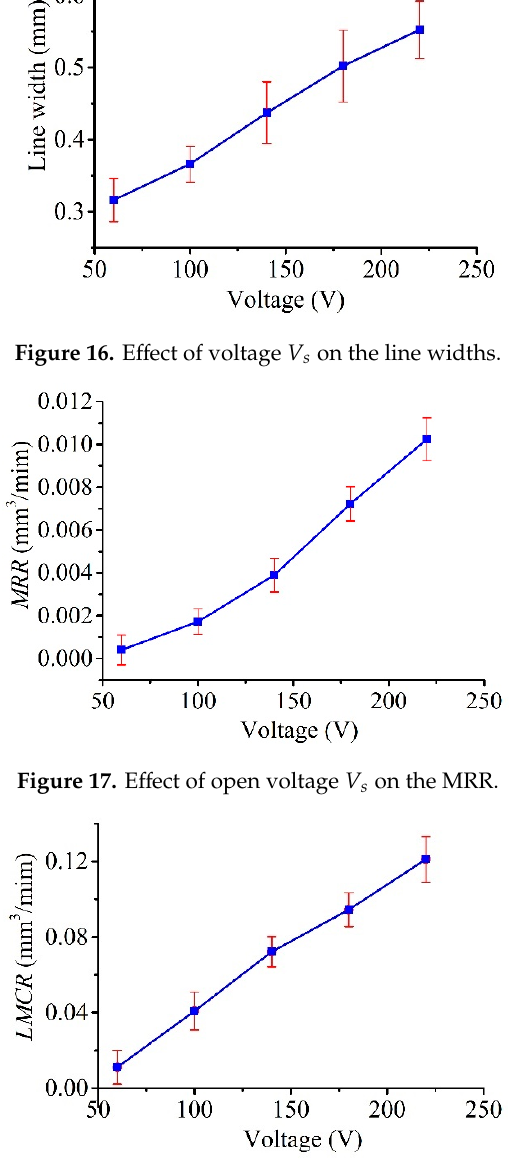
Figure 18. E ff ect of voltage V s on the Figure 18. Effect of voltage V s on the LMCR.